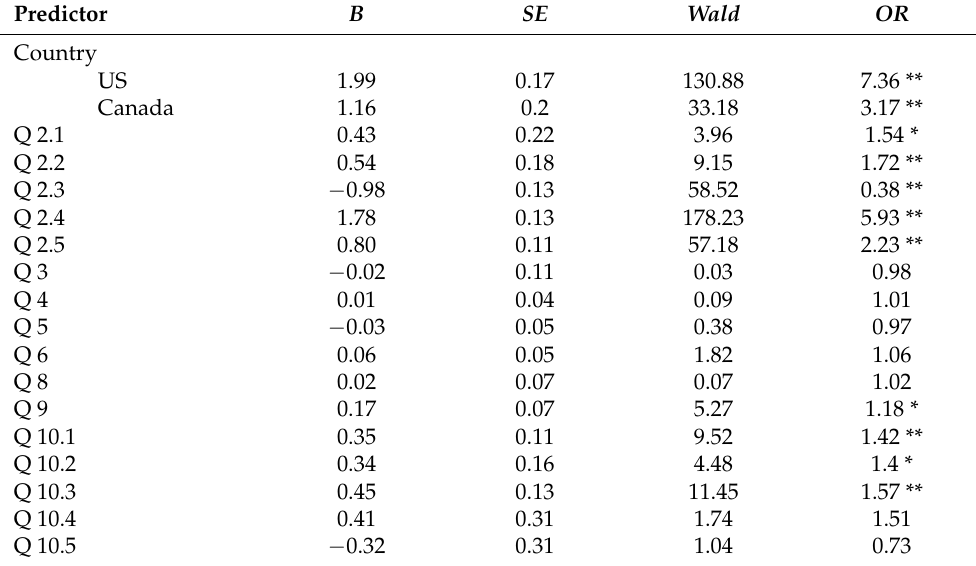
Table 6. Binary logistic regression model predicting position on radiographing chiropractic patients.